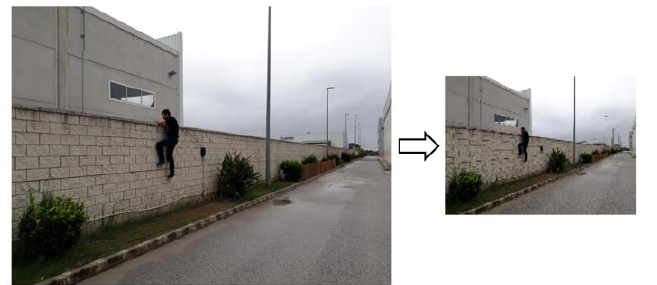
Sensors 2021 , 21 , 7379